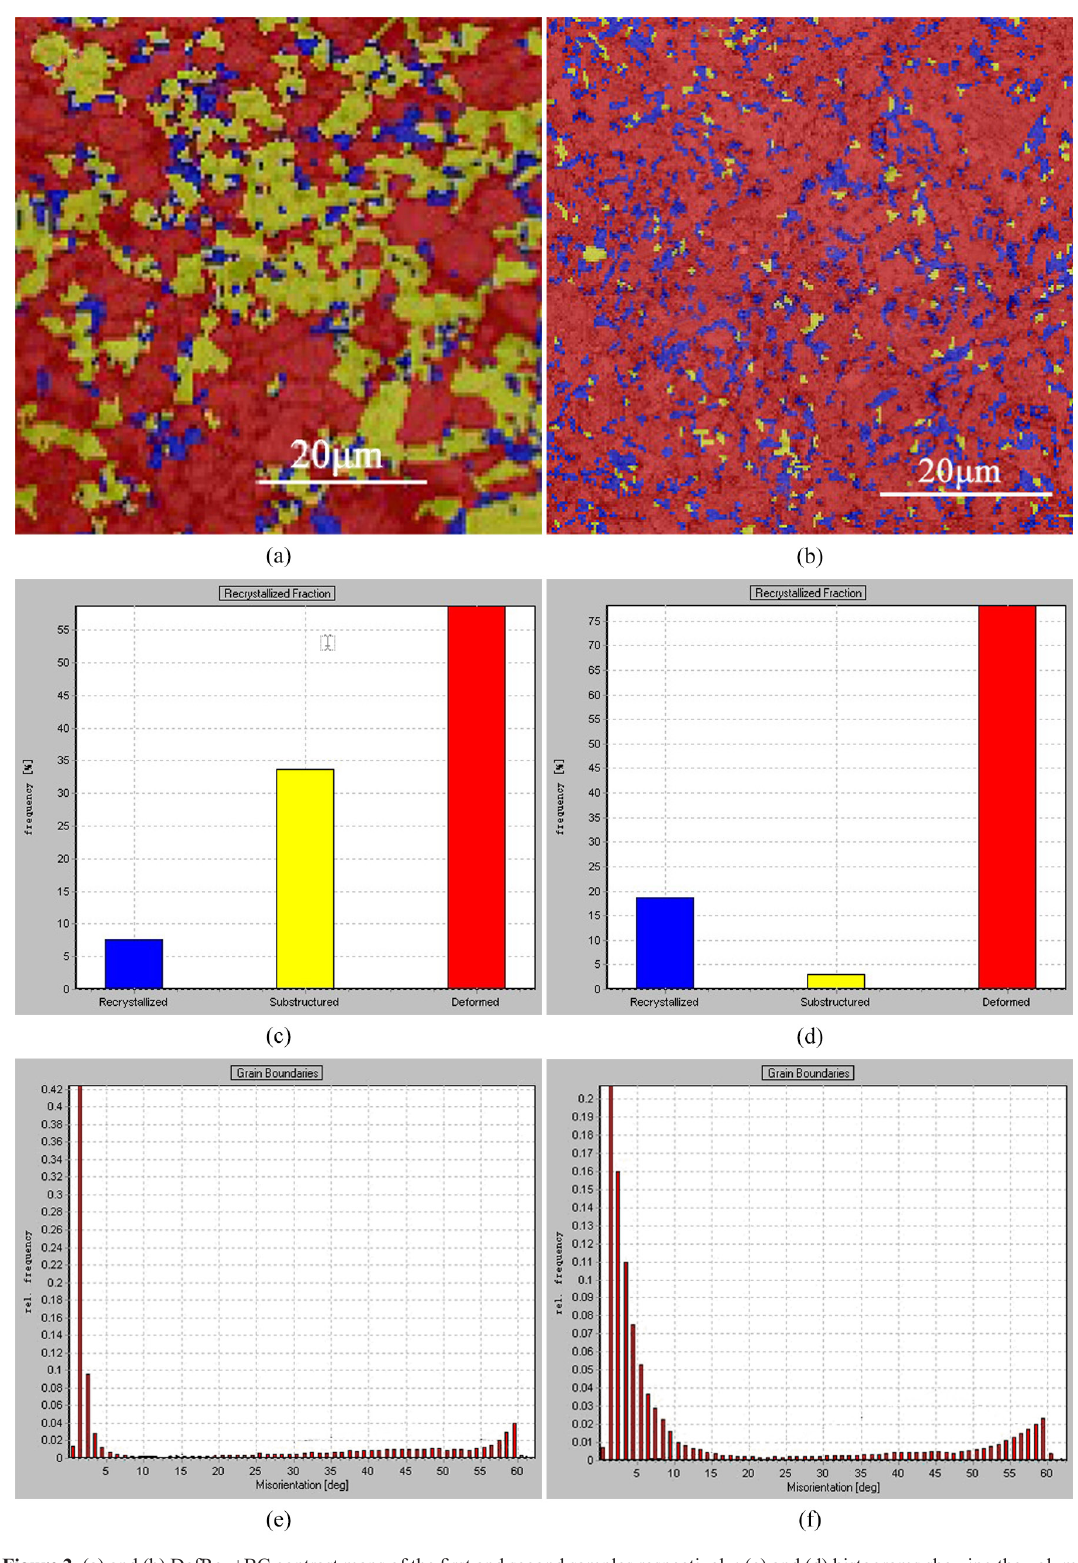
Figure 2. (a) and (b) DefRex+BC contrast maps of the first and second samples respectively; (c) and (d) histograms showing the volume fractions of the recrystallized grains, grains with substructures and deformed grains in the microstructures of the first and second copper samples respectively; (e) and (f) histograms showing the distribution of the grain boundary misorientations in the microstructures of the first and second copper samples